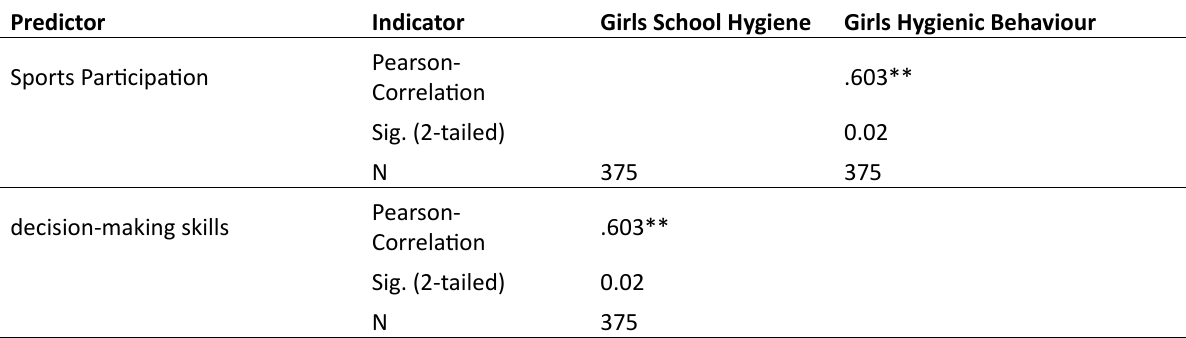
Table 4. Pearson correlation showing the association of sports participation the development of decision-making skills. Predictor